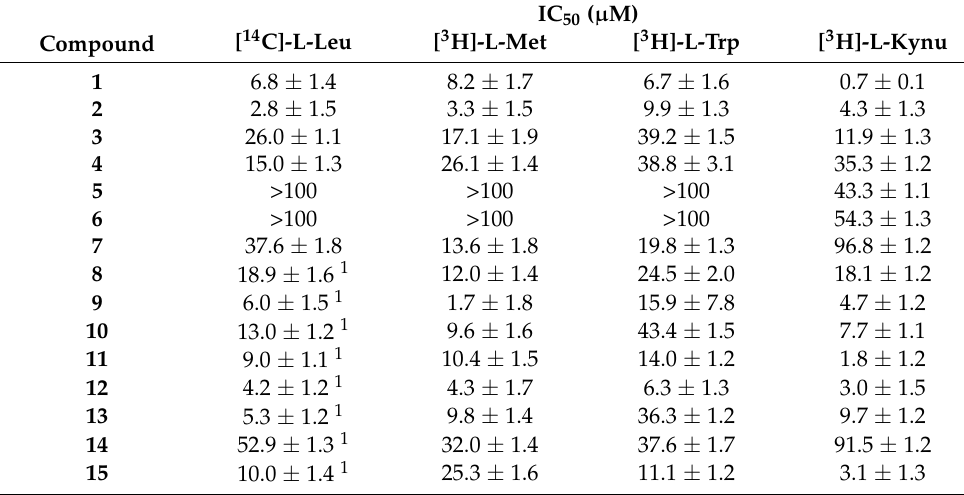
Table 1. The ability of LAT1-utilizing compounds ( 1 – 15 ) to bind LAT1 and inhibit cellular amino acid uptake into immortalized mouse microglia (BV2 cells) presented as half-maximal inhibitory concentrations (IC 50 values) of selected probe substrates ([14C]-L-Leu, [3H]-L-Met, [3H]-L-Trp, [3H]- L-Kynu) uptake. The data are presented as mean ± SD, n = 3–4.